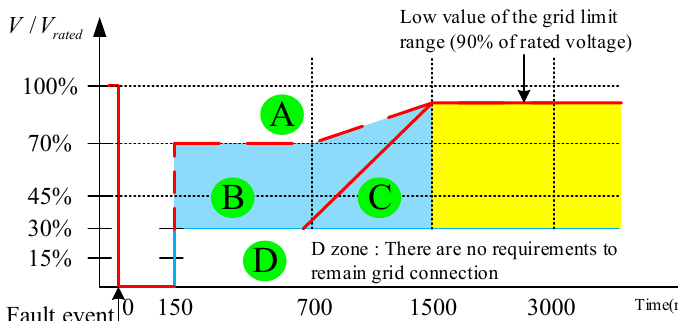
Figure 1. Requirements for FRT by German Grid Code.